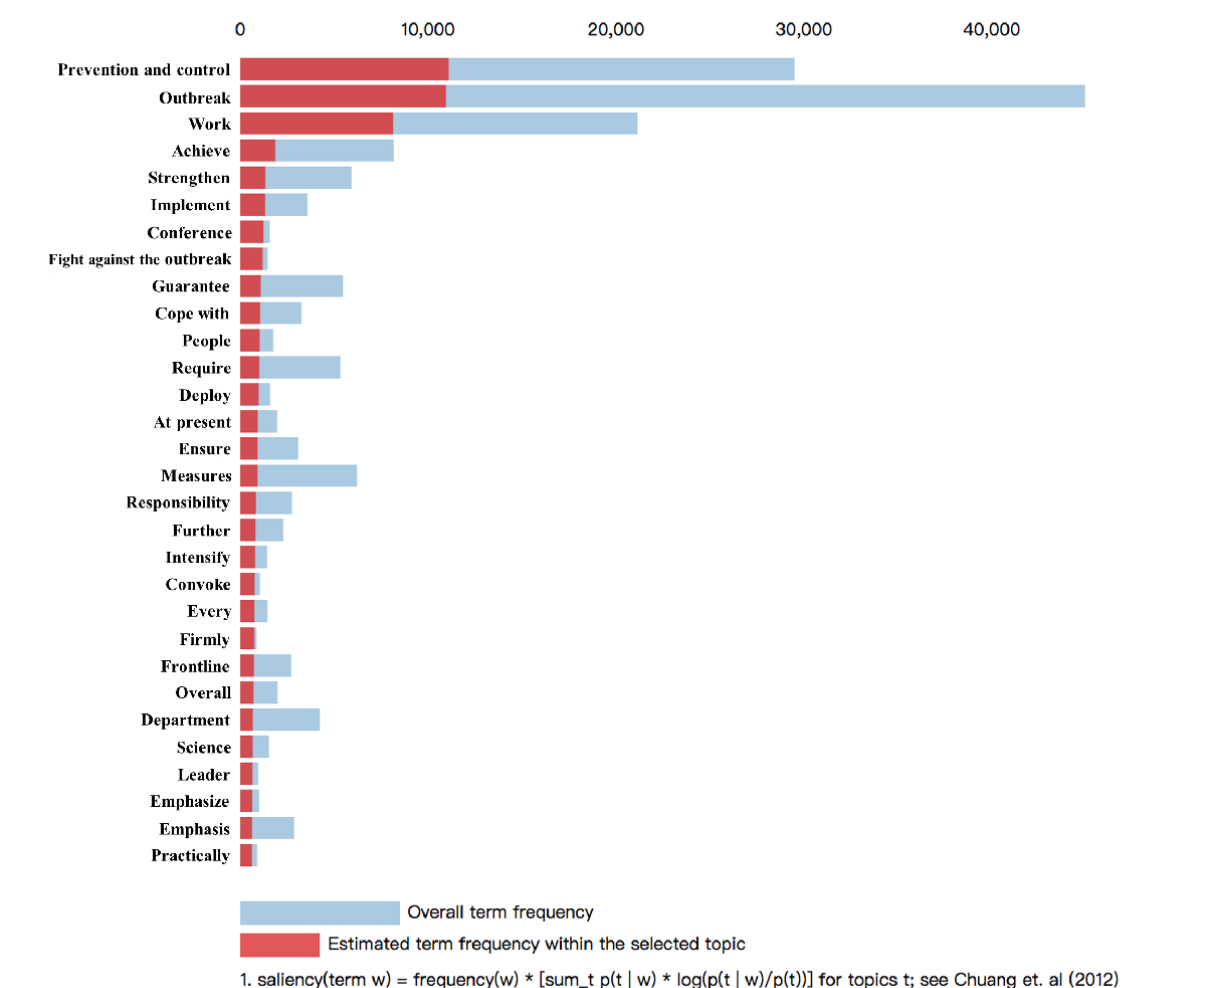
Figure 4. Top 30 most relevant terms for Topic 1 (7.18% of